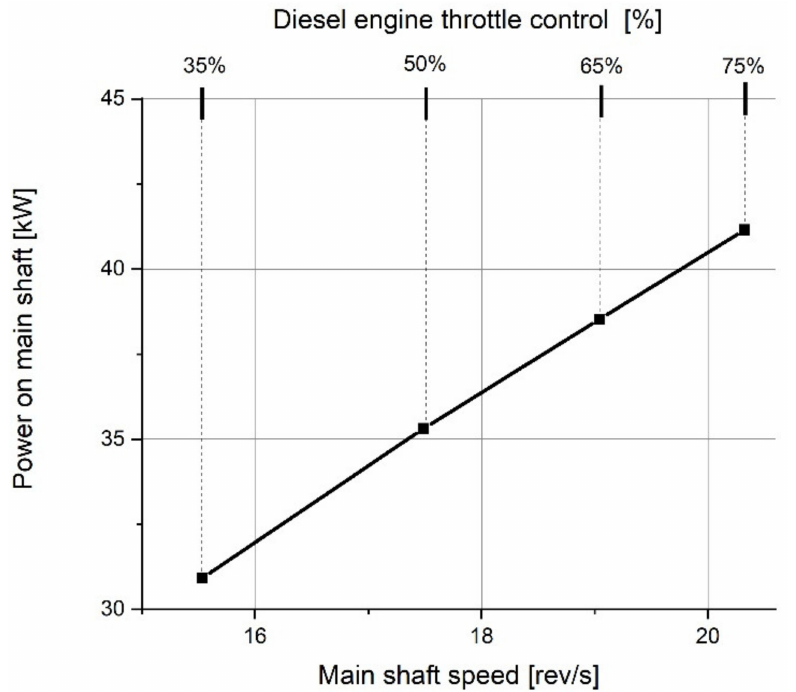
Figure 9. Power on the main shaft in diesel